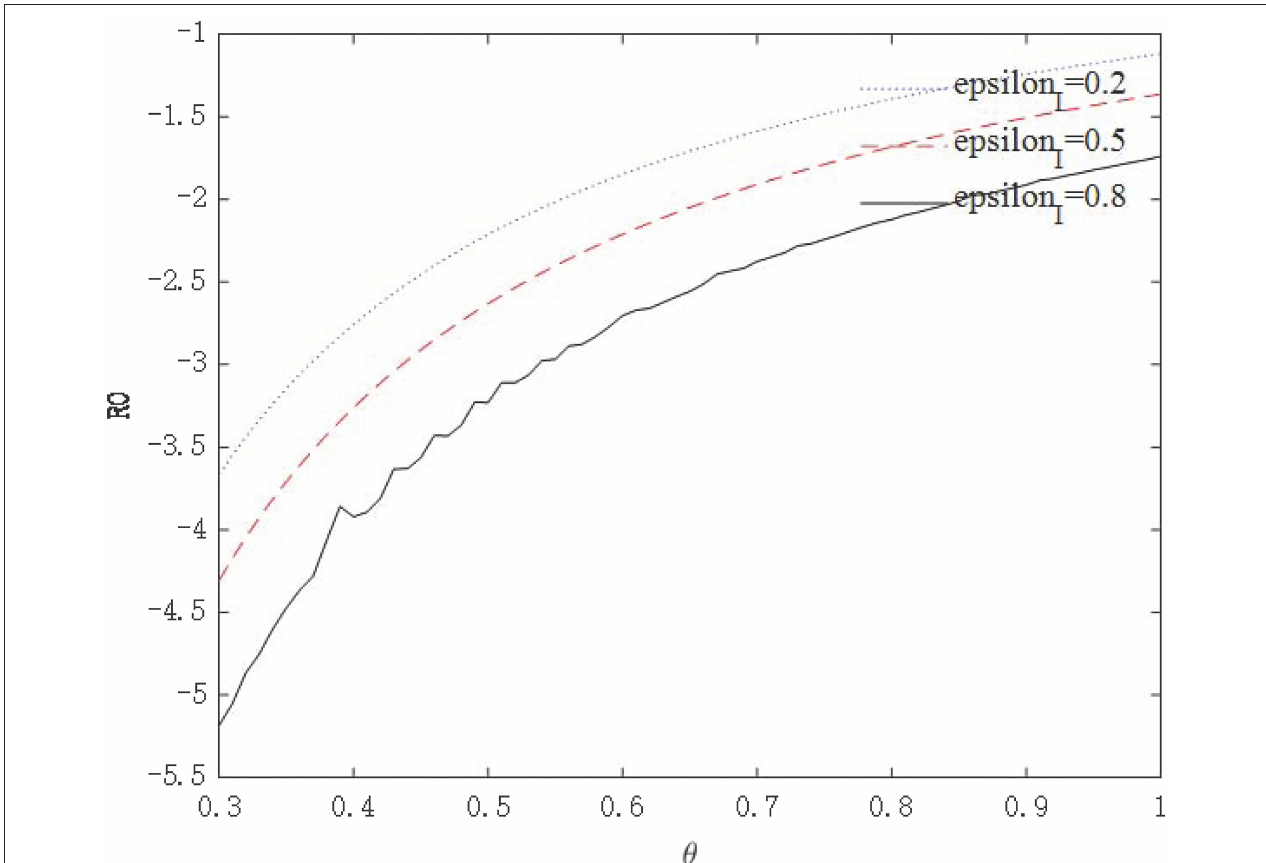
FIGURE 10 | The relationship between R 0 and θ under isolation